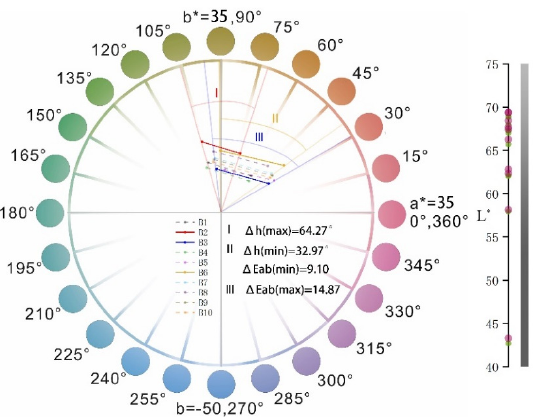
Figure 11. The differences in chroma and colour under the D65 and A light sources in CIE1976 L*a*b* colour space.